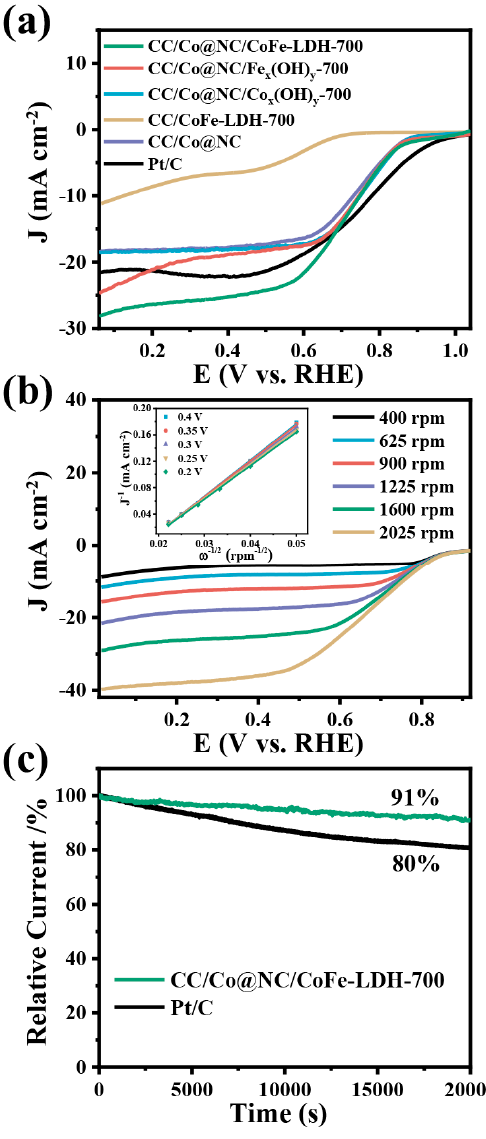
Figure 5. ( a ) ORR polarization curves of related samples at a rotation speed of 1600 rpm and a scan rate of 10 mV/s. ( b ) LSV curves of CC/Co@NC/CoFe-LDH-700 at different rotation speeds, and the inset is the corresponding K–L plots at various potentials. ( c ) Normalized chronoamperometric curves of CC/Co@NC/CoFe-LDH-700 and Pt/C at 0.4 V.